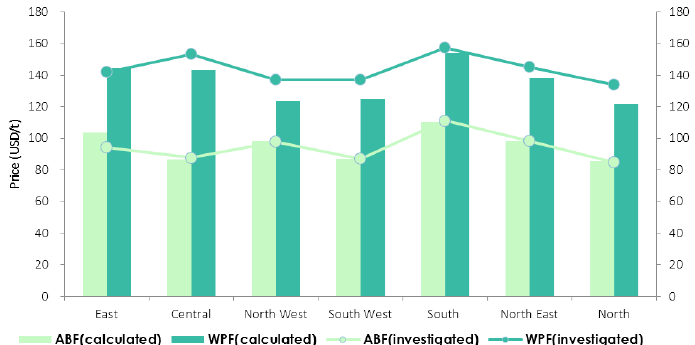
Figure 8. Calculated and investigated regional production costs of BMF in China.